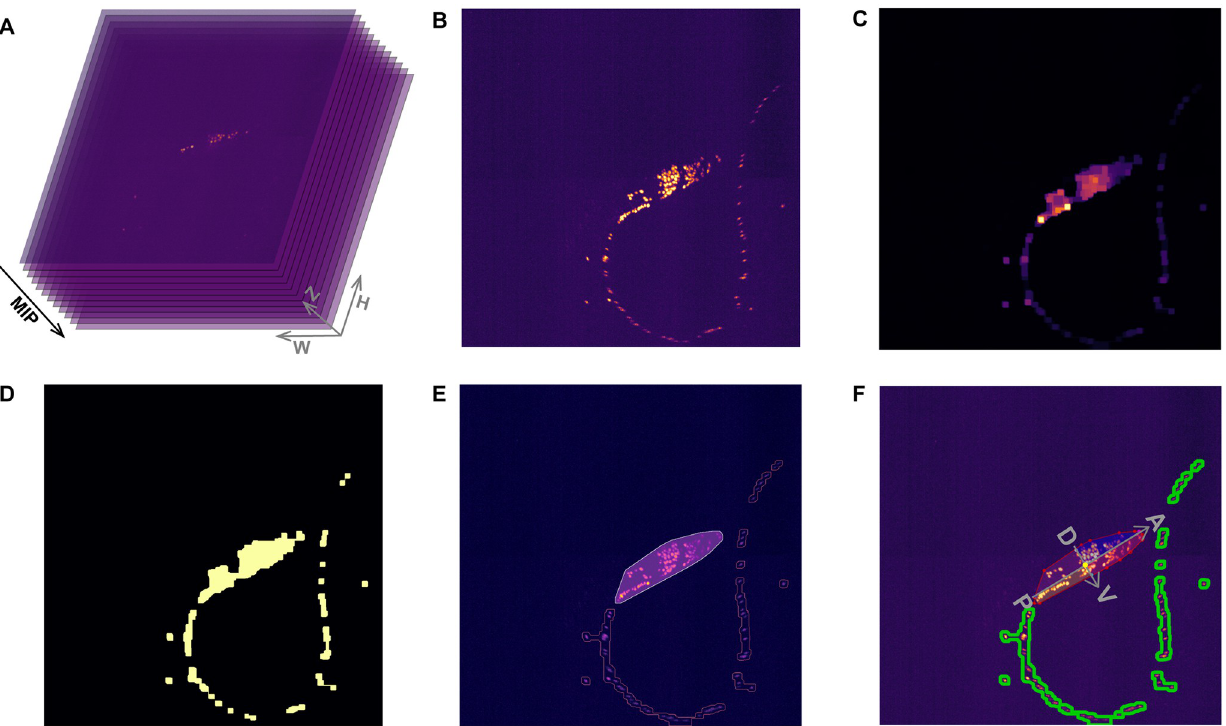
Fig 2. Automatic Pre-Processing (APP). (A) A RFP imaging volume. (B) Maximum Intensity Projection (MIP) of the imaging volume. Brighter pixels represent fluorescence signals. (C) Noises are reduced by median blur filters; a closing operation connects neighboring pixels, from which the worm head region will be extracted. (D) A dynamic threshold algorithm converts (C) into a binary image. (E) A contour finding algorithm identifies a series of separate regions. The largest area (yellow contour with a purple mask) is the head region; the rest are body regions (pink contour). (F) A C. elegans coordinate system is built for the head region. The yellow point represents the center of mass. A: anterior, P: posterior, V: ventral and D: dorsal.